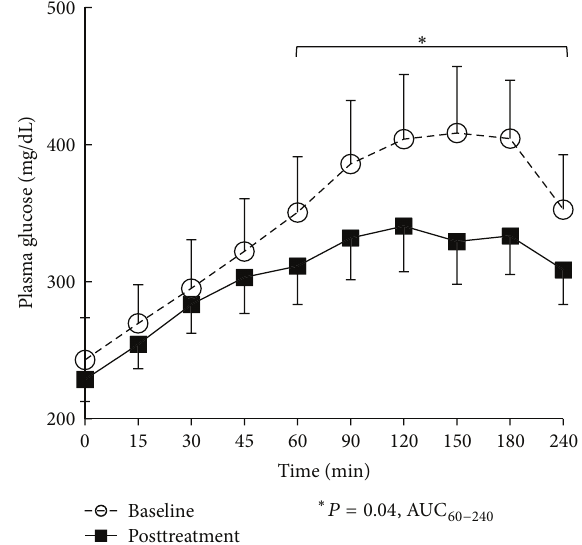
Figure 2: Effect of bromocriptine-QR therapy on mixed meal toler- ance test postprandial glucose area under the curve (AUC) over 24 weeks in subjects on metformin plus high-dose basal-bolus insulin therapy at